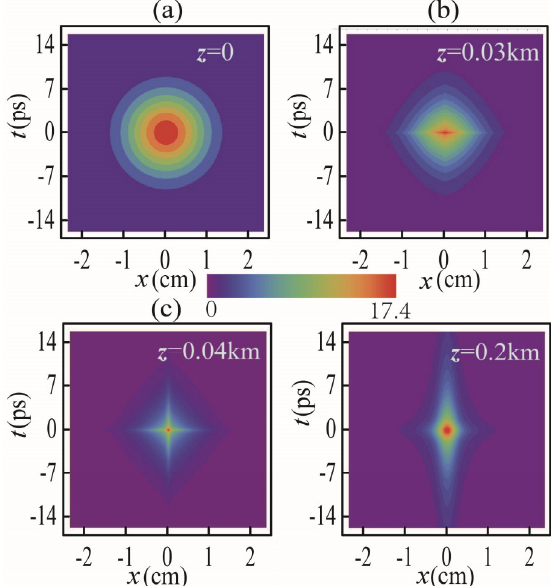
Figure 6. Contour graph of normalized spatial-temporal intensity distribution I ( x , t , z ) of PCP beams with Gaussian weight function at z plane with different values of z : ( a ) z = 0, ( b ) z = 0.03 km, ( c ) z = 0.04 km and ( d ) z = 0.2 km in the x - t plane.